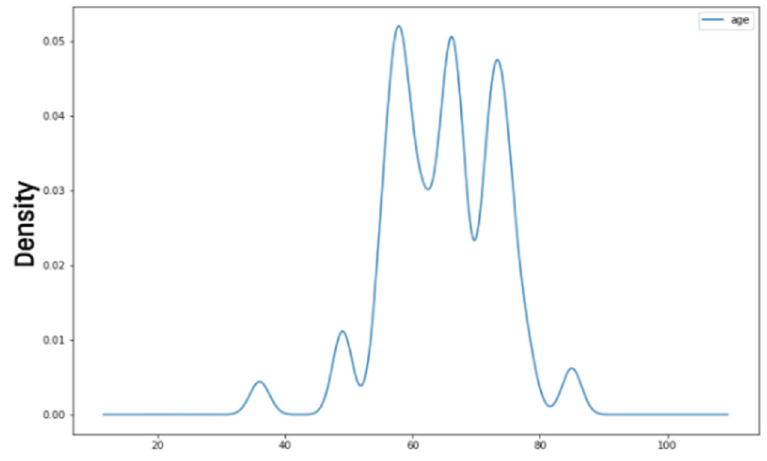
Figure 4. Age Density graphs.